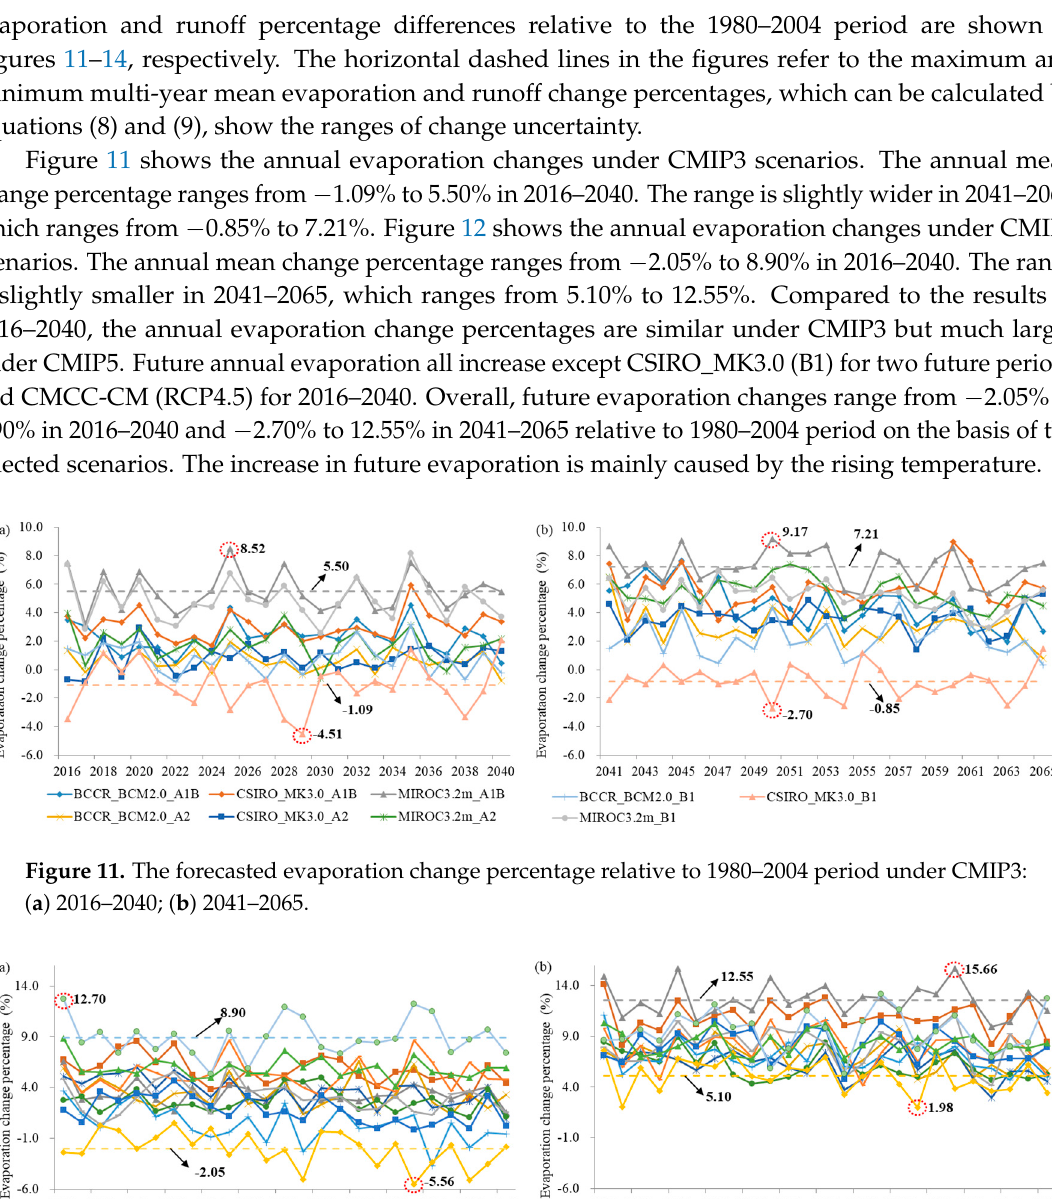
Figure 13. The forecasted runoff change percentage relative to 1980–2004 period under CMIP3: ( a )